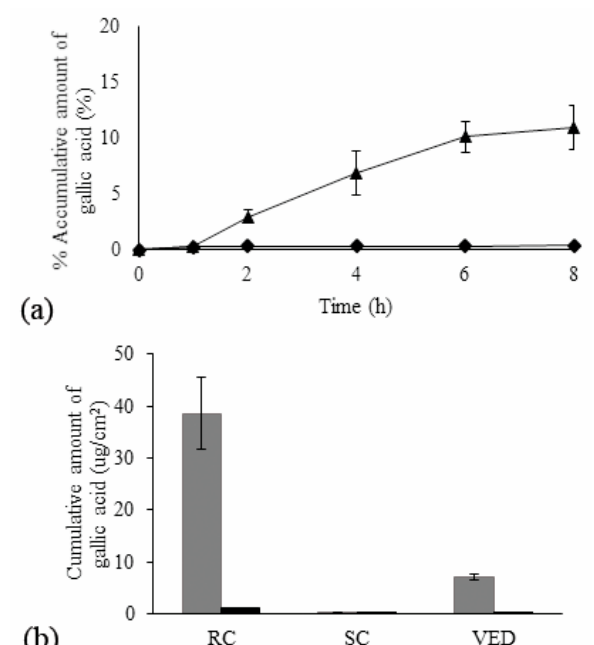
Figure 6. Percentage accumulative of gallic acid in receiving compartment ( a ) ; ( ) N2 - EF and ( ) ) EF - solution along with cumulative amount of gallic acid through skin per unit surface area after 8 h ( Q 8 ) in different layers ( b ) ; RC — receiver compartment, SC — stratum corneum, and VED — viable epidermis dermis; (  ) N2 - EF and (  ) EF - solution ( mean ± SD; n = 3 ) .